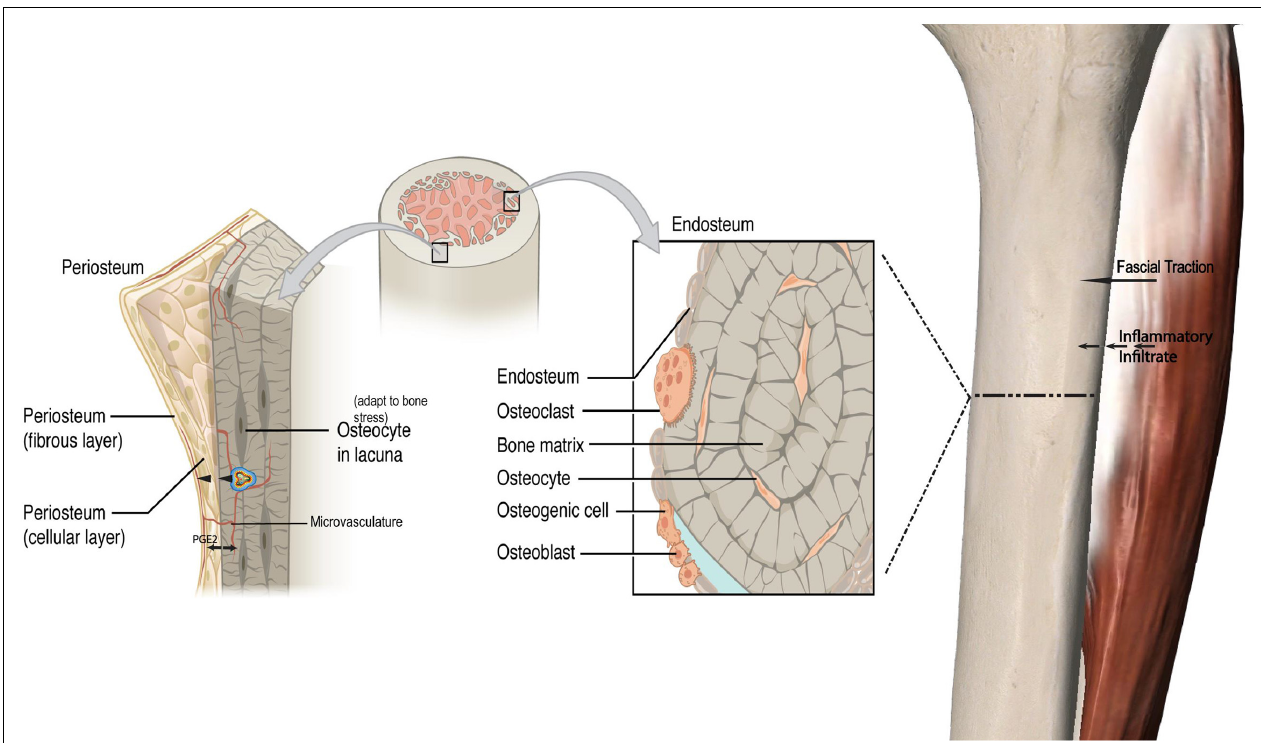
FIGURE 1 | Fascial-bone stress model. A visual framework depicting a proposed pathway of an outside-in model for bone remodeling with a local inflammatory response via fascial traction and resultant bony response with impact on periosteal osteoblasts and increased production of PGE2. Similar to the outside-in model with cascade of inflammatory processes coming from fascial layers into periosteum and endocortex, a proposed inside-out mechanism is illustrated. This load induced bone stress response along with increased vasculature and inflammatory cytokines originating from the endocortex drives periosteal change in addition to crosstalk between the endocortical and periosteal layers. PGE2 Prostaglandin E2. The cell in cocentric multicolor lines represent an inflammatory cytokine (not to scale). Adapted from